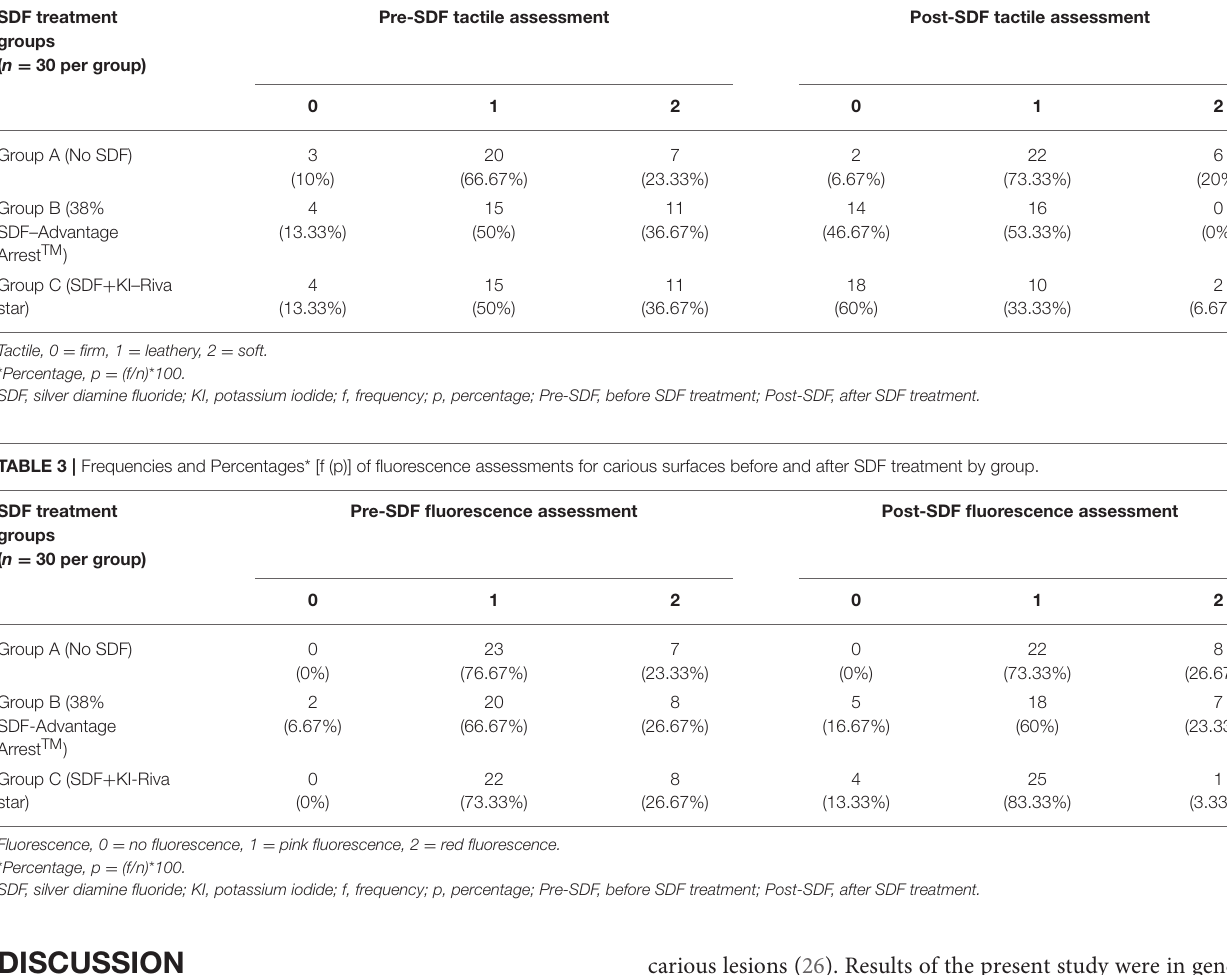
TABLE 2 | Frequencies and Percentages* [f (p)] of tactile assessments for carious surfaces before and after SDF treatment by groups. SDF treatment groups ( n = 30 per group)